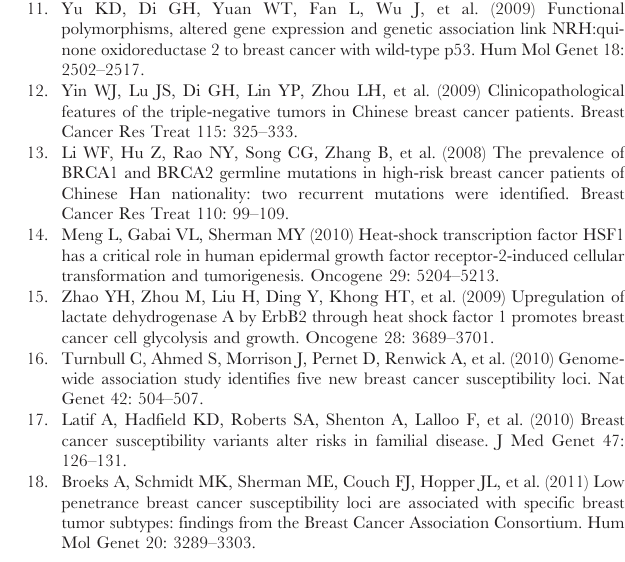
Table S1 Associations between rs4919510:C . G and breast cancer risk in the overall population and in the IDC cases in the first set. Table S2 Associations of rs4919510:C . G genotype with breast tumor size and lymph nodes status in HER2-positive IDC cases in the first